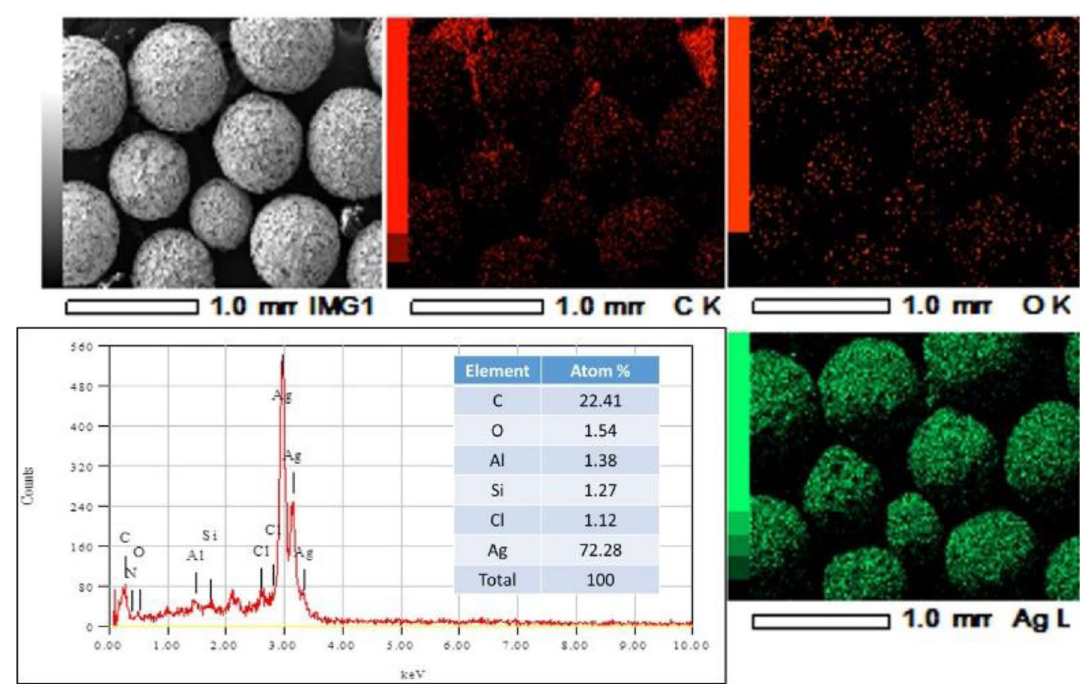
Figure 5. SEM–EDX mapping analysis of resin@ P-Ag 2 O